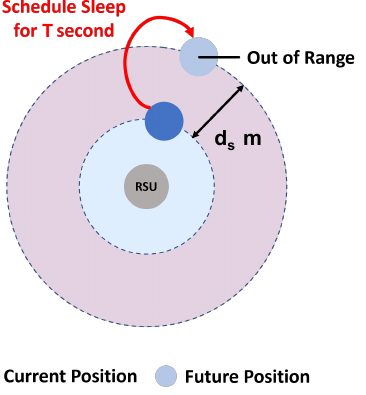
Figure 6. Illustration of the sleeping situation of a mobile node